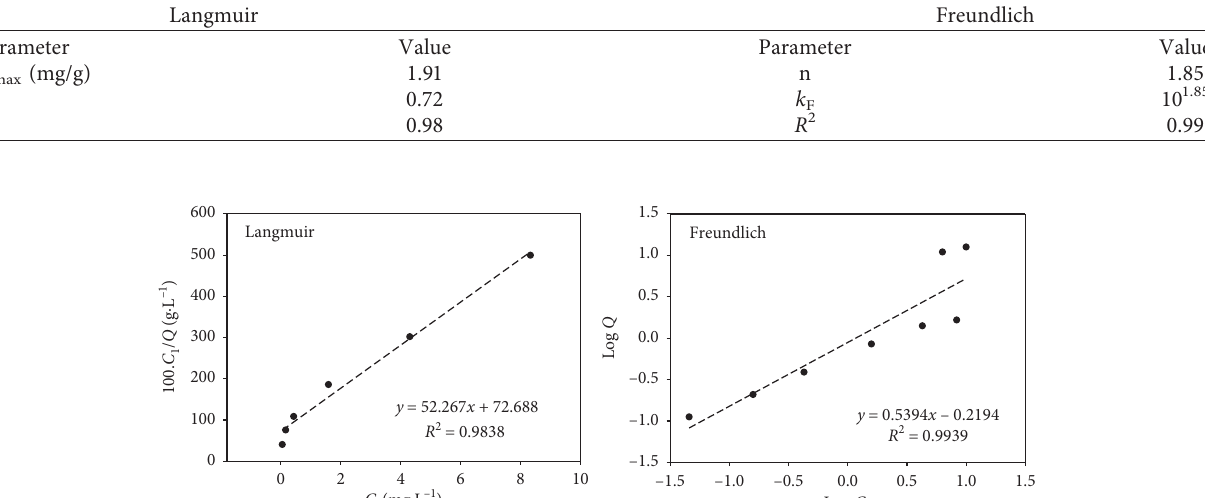
Table 7: Comparison of maximum adsorption capacity ( Q Adsorbent